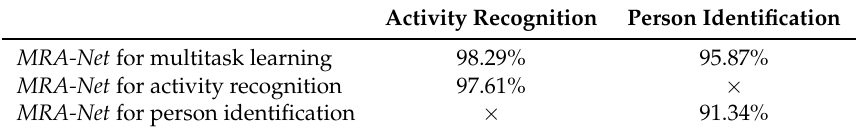
Table 4. Test F1-scores of MRA-Net for multitask learning and single-task